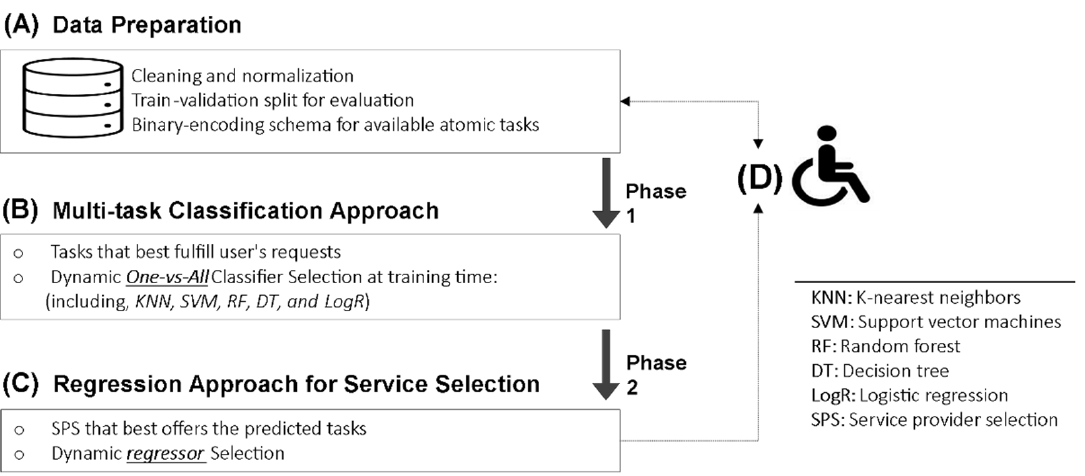
Figure 5. The proposed two-phase service selection approach for finding assistive services. Key phases include (1) multi-label task classification and (2) service provider-to-task matchmaking using a regressor. Algorithm 1: Training procedure to select the best accuracy classifier, C ∗ .